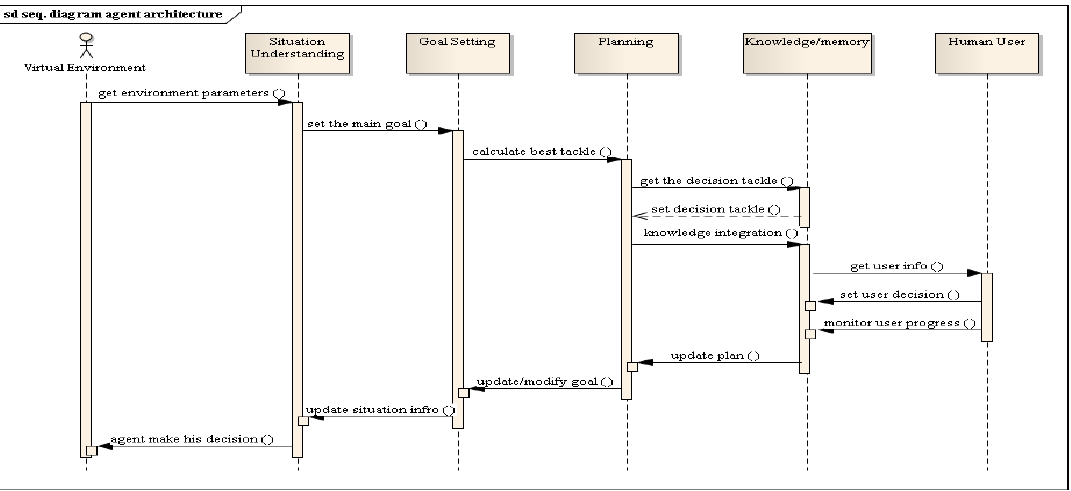
Figure 4. Flow between the modules in the agent architecture.